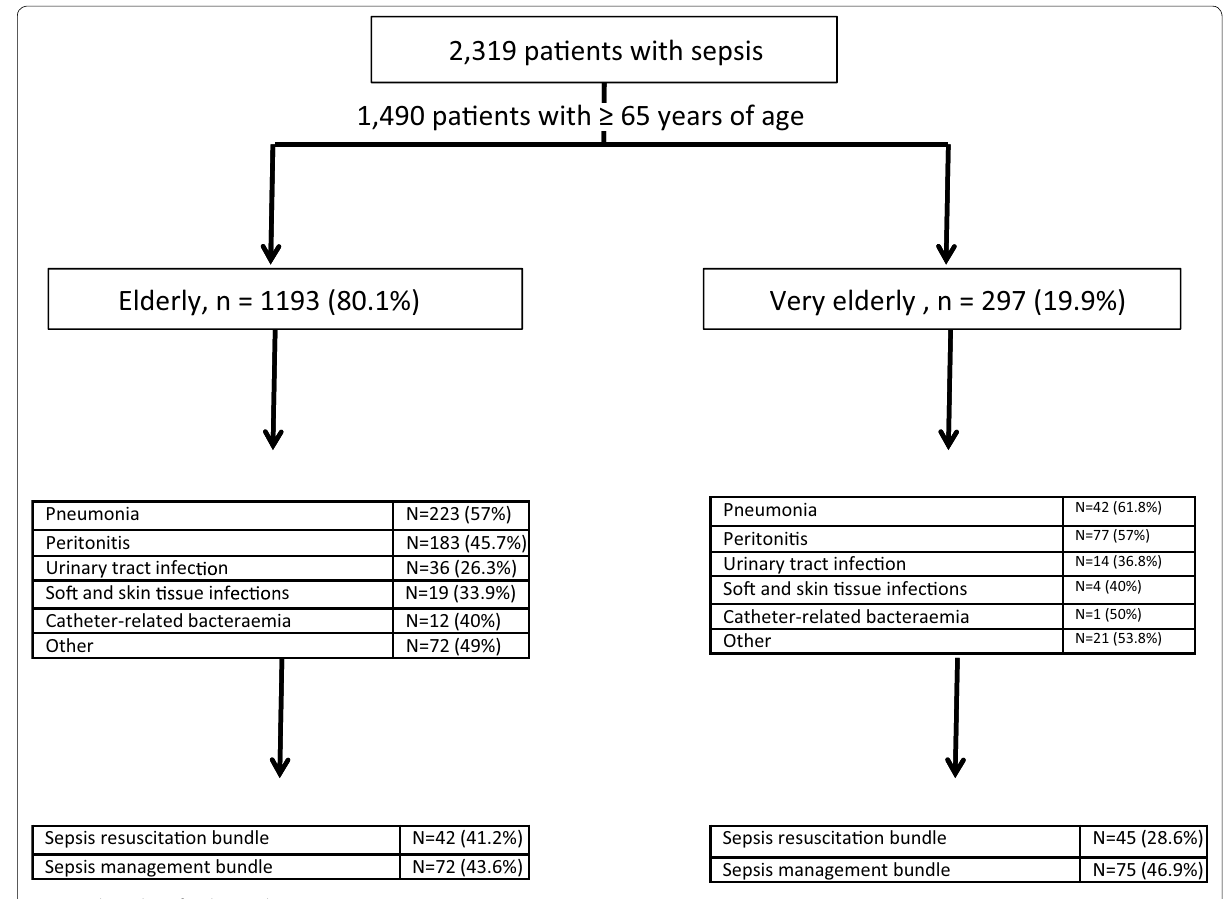
Fig. 1 Flow chart for the